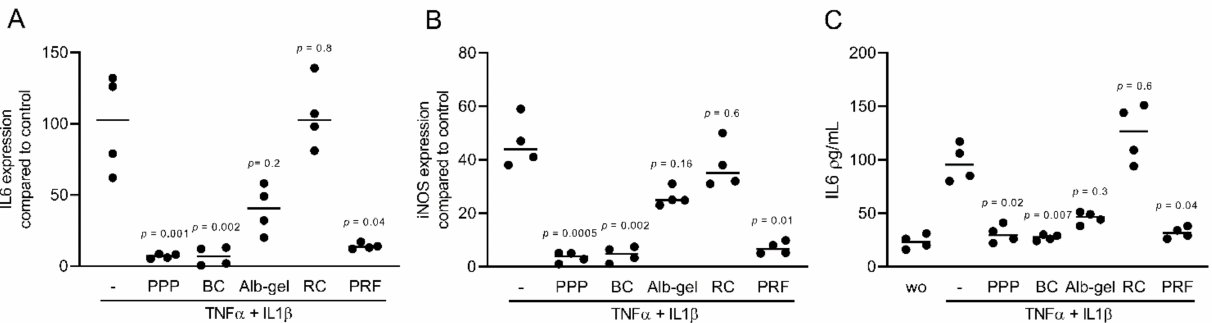
Figure 1. PPP, BC, and PRF lysates reduced cytokine-induced inflammation in murine ST2 cells. ST2 cells were treated with 10% of PPP, BC, Alb-gel, RC, and 30% of PRF in the presence of the inflammatory cytokines TNF α and IL1 β . ( A , B ) Data indicate the x-fold changes of IL6 and iNOS gene expression ( C ) and the IL6 levels in the cell supernatant, n = 4. WO means without and represents unstimulated cells.